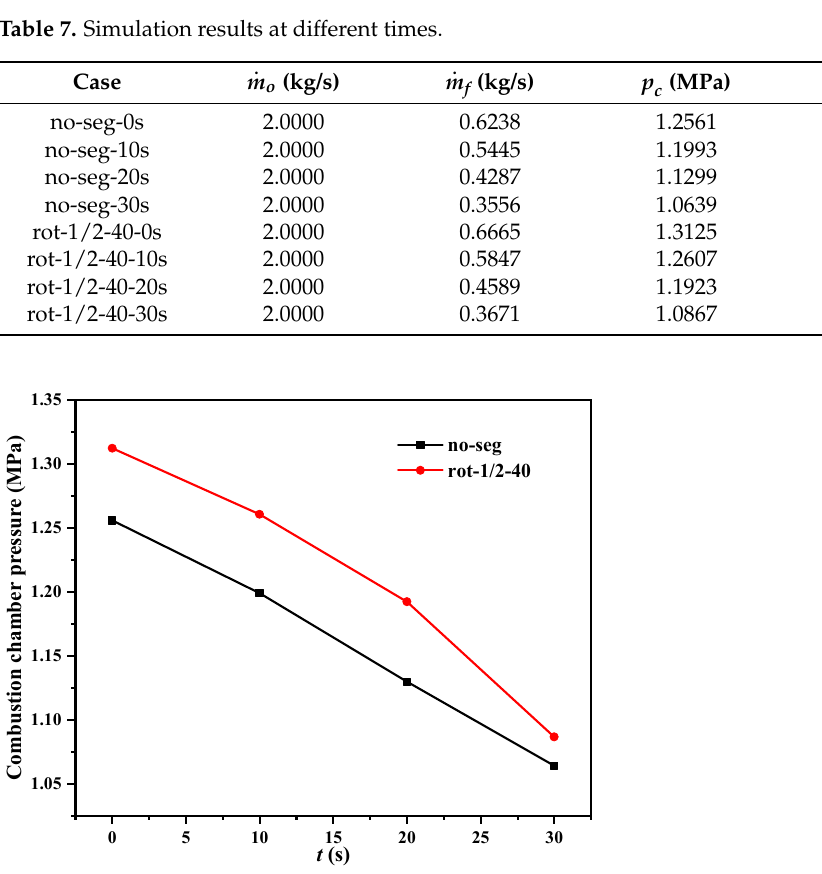
Figure 33. Thrust history in cases no-seg and rot-1/2-40. Figures 34 and Figure 35 show the average fuel regression rate and combustion effi- ciency at different times in cases no-seg and rot-1/2-40. It is obvious that the average re- gression rate gradually decreases with the increase in the working time, which is due to the increase in grain port diameter. In addition, the average fuel regression rate in case rot-1/2-40 is higher than that in case no-seg, and this indicates that the fuel regression rate can be improved by adopting segmented rotation grain configuration during the entire period of operation. For case no-seg, when the working time increases, the grain inner surface regresses and it is gradually farther from the oxidizer. Thus, the mixing of the fuel and oxidizer is worse, which decreases the combustion efficiency. For case rot-1/2-40, when the working time increases, the disturbing effect of the front-end face of the after- section grain weakens, and thus the mixing of the propellants is gradually insufficient. This reduces the combustion efficiency. The combustion efficiency in case rot-1/2-40 is higher than that in case no-seg, and it improves by 1.40 – 4.21%. Therefore, a conclusion can be drawn that the combustion efficiency of hybrid rocket motors with segmented ro- tation grain can be increased in the whole motor operation.